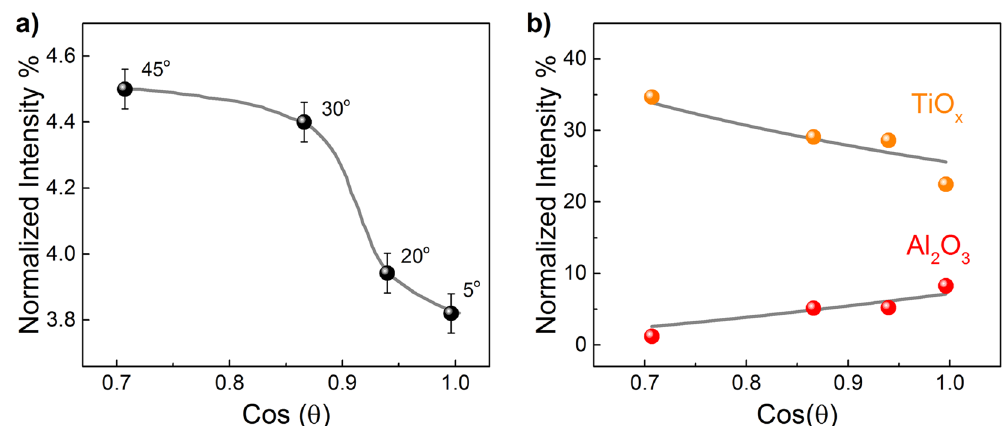
Figure 4. Relative fraction of N 2 peak (centered at 402 eV) in the whole intensity of N1s line ( a ) and Ti 4 + (TiO x ) and Al2s (Al 2 O 3 ) peaks ( b ) measured using 3010 eV excitation photons and different electron emission angles. The typical error margin was about